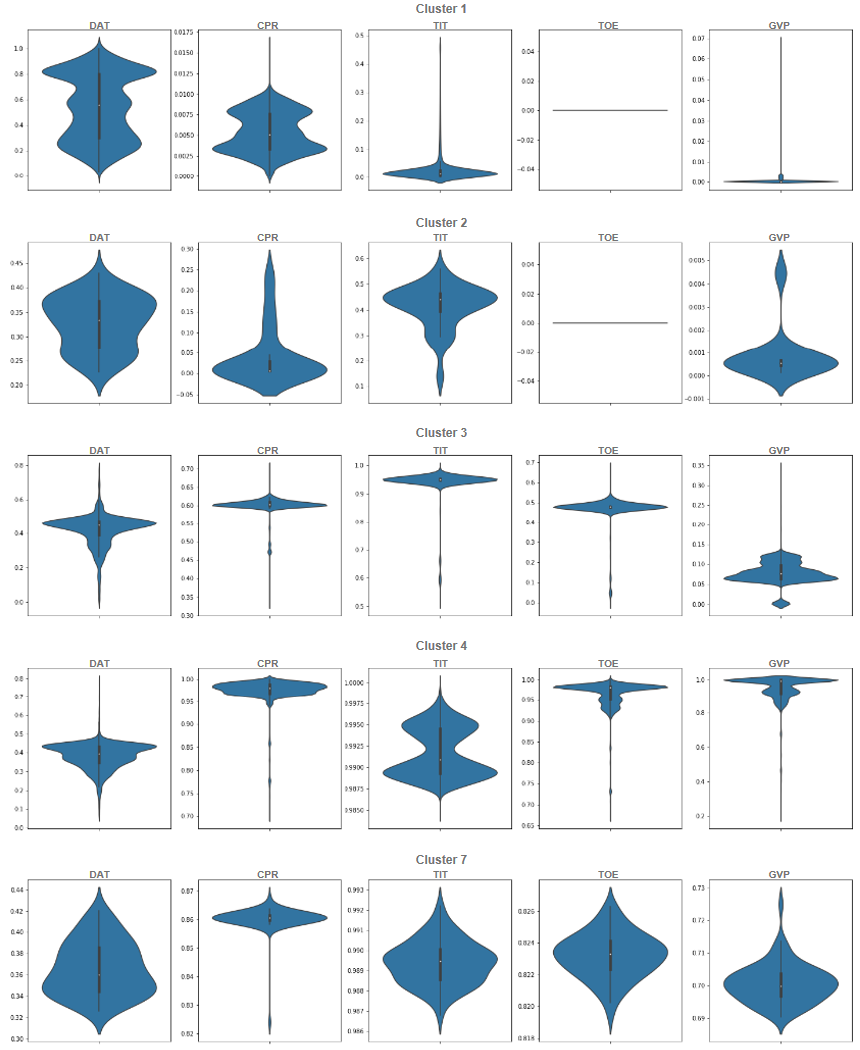
Figure 14. Violin plot of each individual cluster in the ensemble of clusters, with a cluster consistency of 80% for the normalized selected features. Table 4. A summary of the clusters’ interpretation obtained with the 0.80